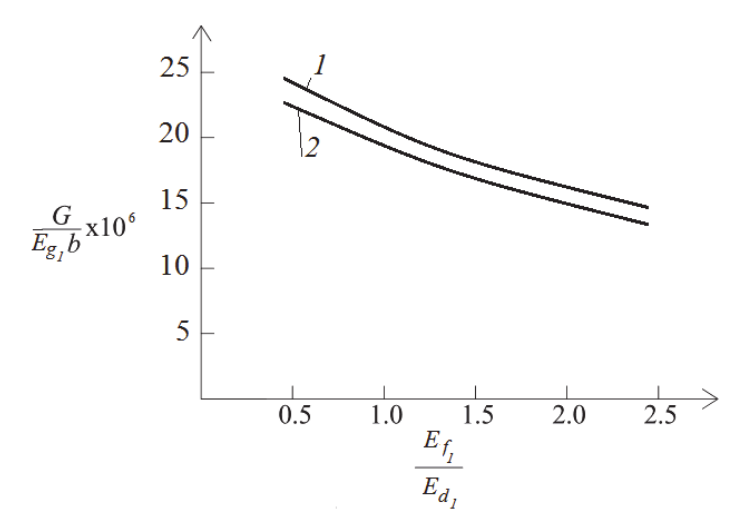
Figure 6: The strain energy release rate in non-dimensional form presented as a function of